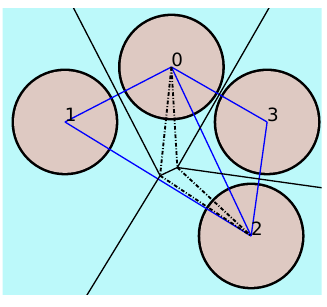
Figure 6. Layout where wire 0 and 2 have an indirect